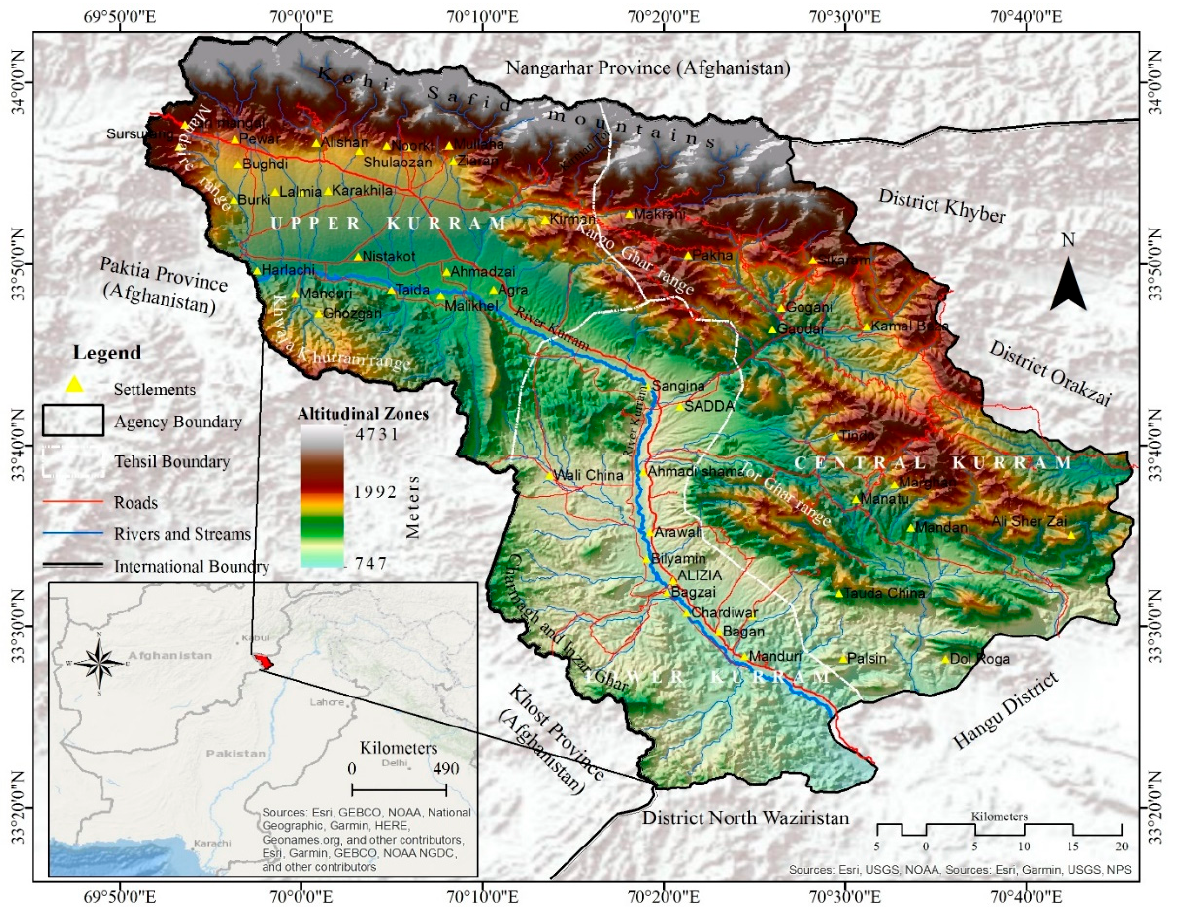
Figure 1. Location Map of district Kurram, major settlements and roads network.